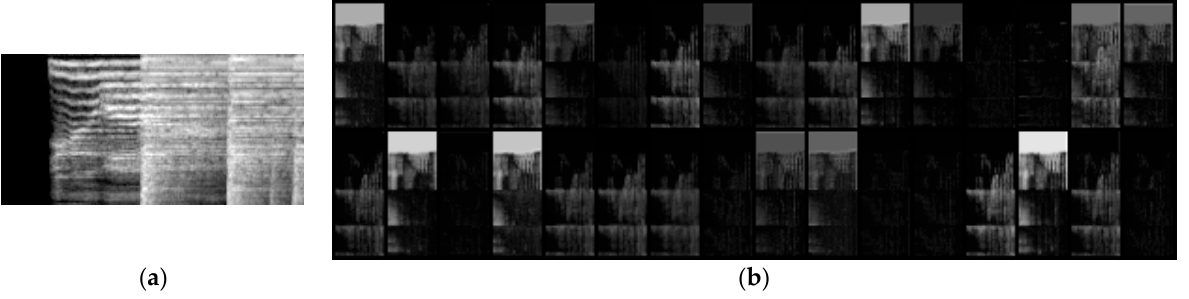
Figure 2. The conventional CNN neurons equally “observe” the feature maps on the upper layer. ( a ) An image from the log-mel spectrogram of the music “you are”, and ( b ) a group of the feature map examples from a CNN inner layer with 64 channels.